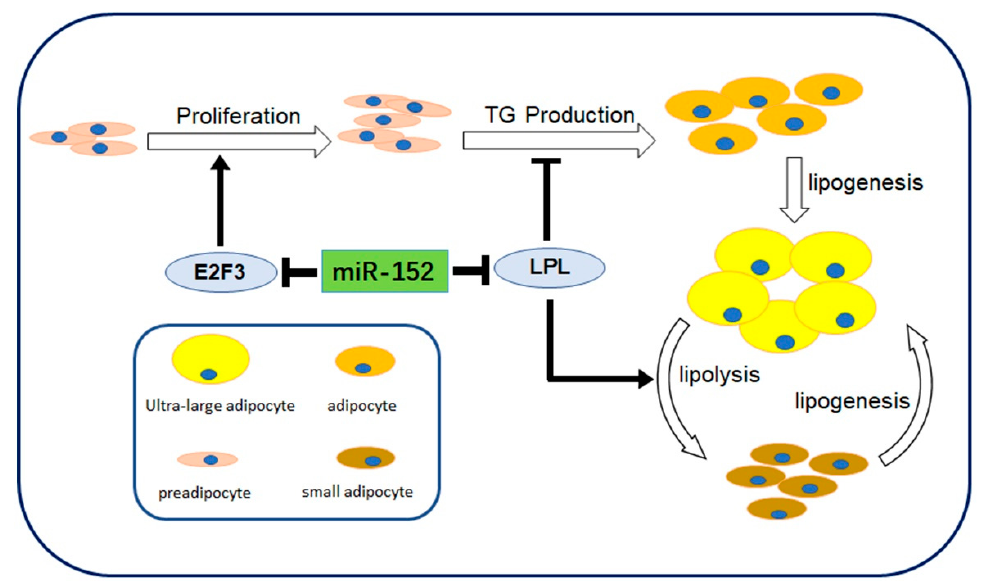
Figure 6. Schematic diagram showing miR-152 roles in 3T3-L1 preadipocyte cells. miR-152 regulates proliferation, triglycerides (TG) production and lipogenesis of small adipocytes by modulating E2F3 and LPL.